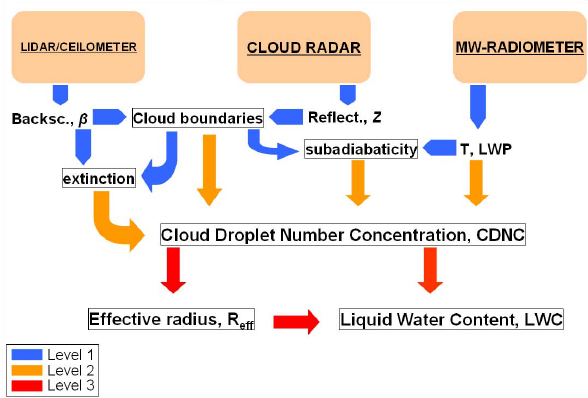
Fig. 2. Outline of SYRSOC: three-level (blue-orange-red) retrieval scheme of cloud microphysical